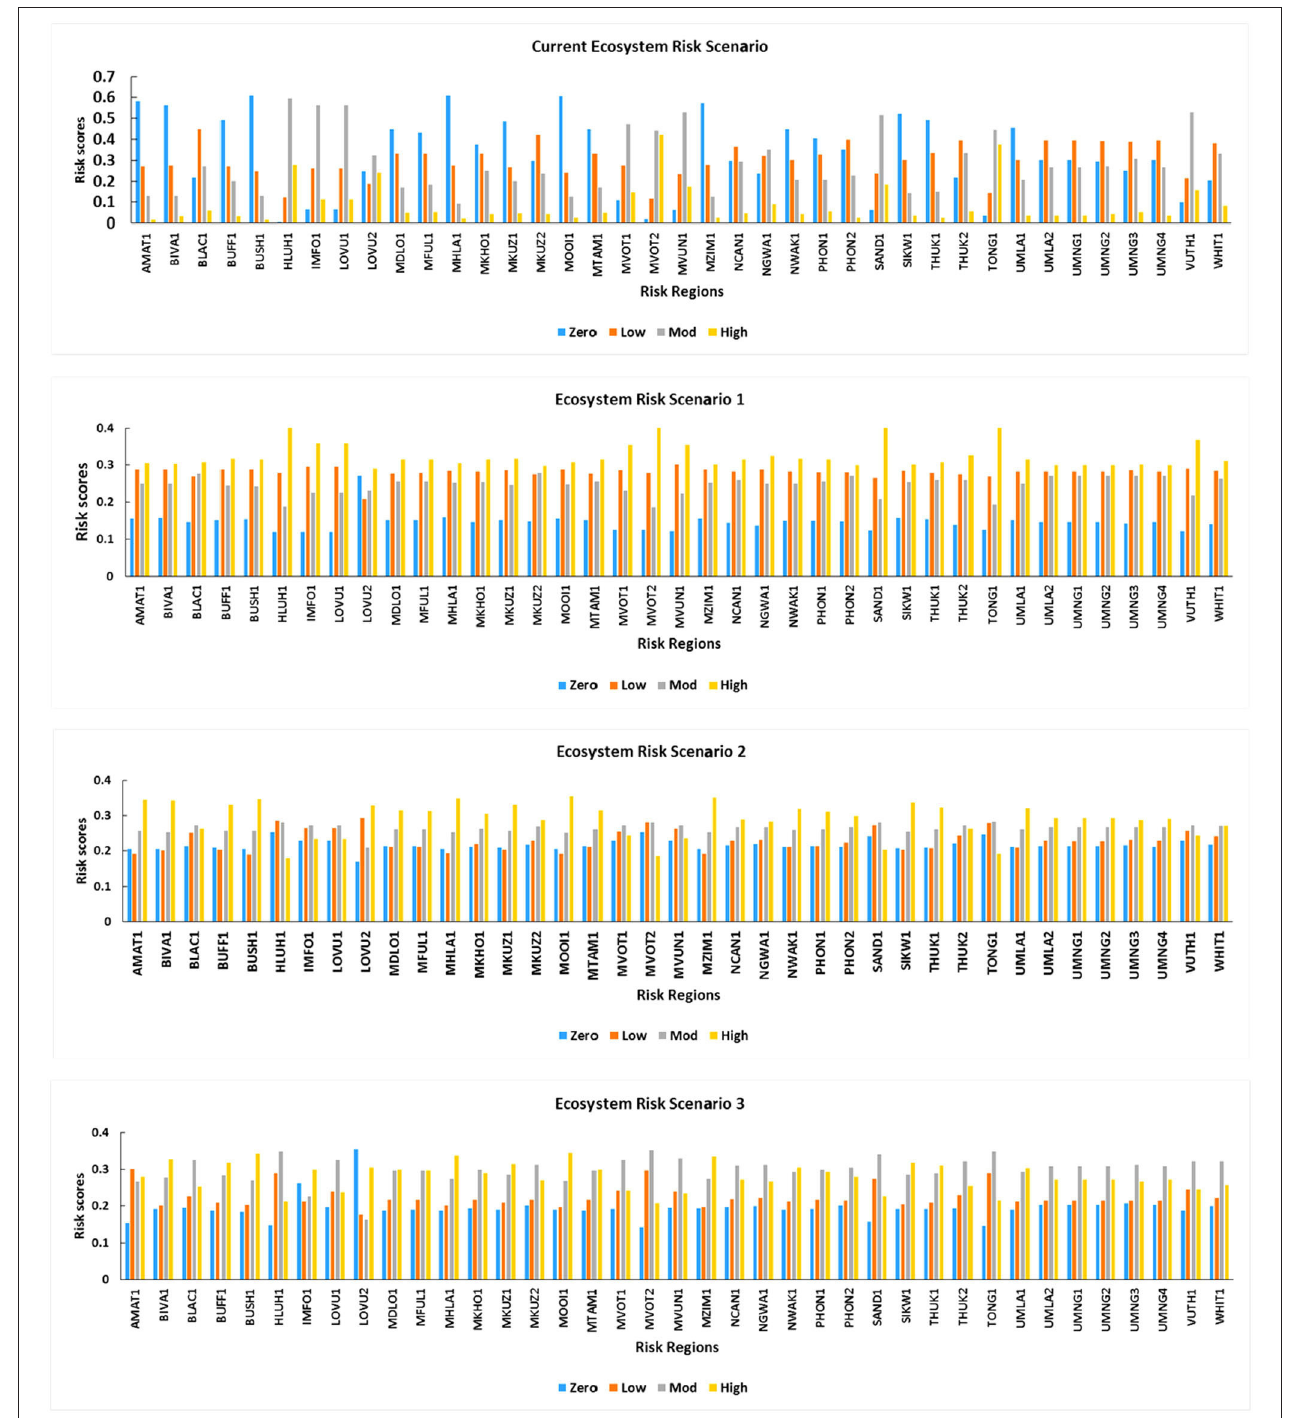
FIGURE 5 | Bayesian network risk distributions across the risk regions and in all scenarios of the ecosystem endpoint.